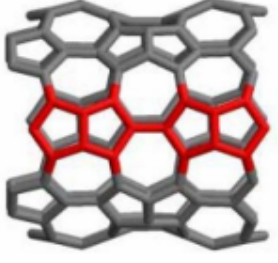
Figure 8. Molecular graph of HC 5 C 7 [ p , q ] .